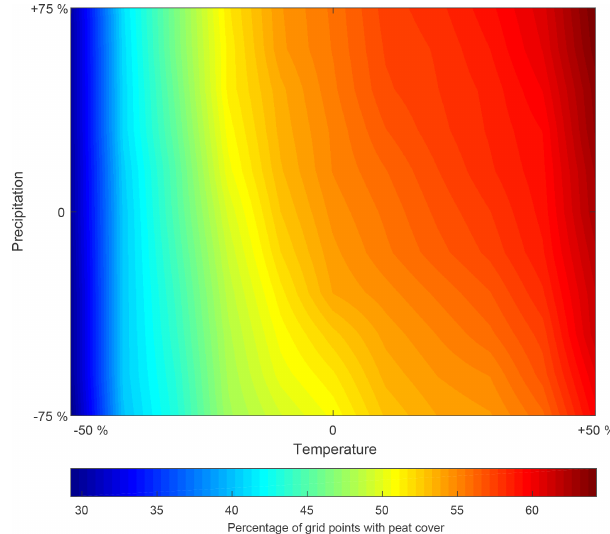
Figure 13. Percentage of all model grid points with a peat cover of at least 10cm for all combinations of precipitation and temperature variations.